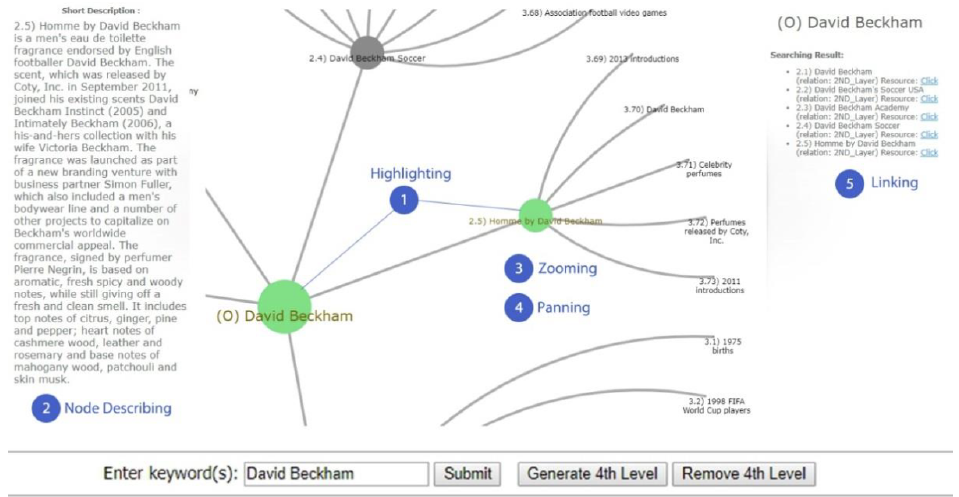
Figure 11. Hyperbolic tree [42]. VSDR displaying search results of keyword “David Beckham”.